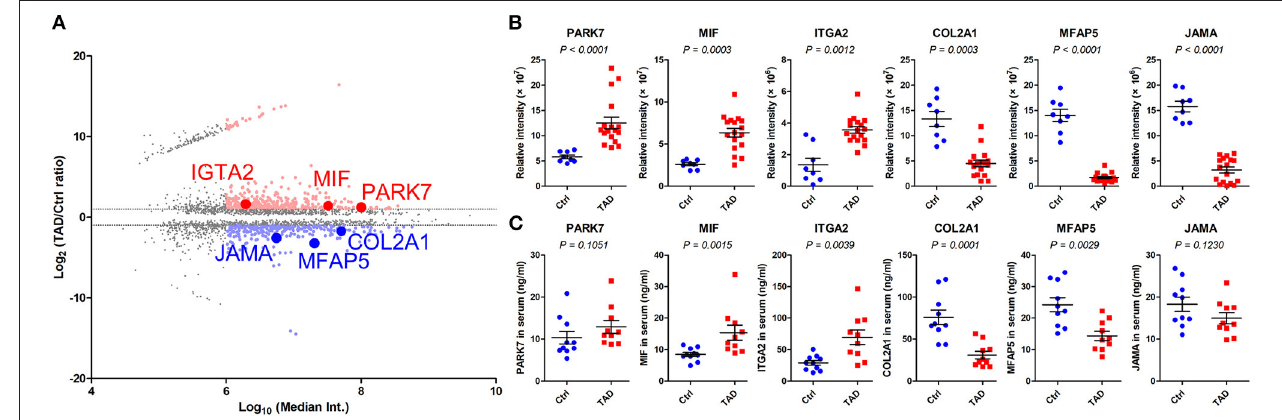
FIGURE 5 | Relative expression of PARK7, MIF, ITGA2, COL2A1, MFAP5, and JAMA in the training phase. (A) MA plot of the comparison of the TAD and control proteomes. The proteins with a P -value < 0.05 are presented, and those with a median intensity over 1 × 10 6 are colored red (upregulated) or blue (downregulated). Six selected proteins, PARK7, MIF, ITGA2, COL2A1, MFAP5, and JAMA, were identified. (B) Relative expression of the six indicated proteins in tissue samples via proteomics analysis in the screening phase. (C) Relative expression of the six indicated proteins in serum samples via ELISAs in the training phase, n = 20. P -values in (B,C) were determined by the Mann-Whitney test.